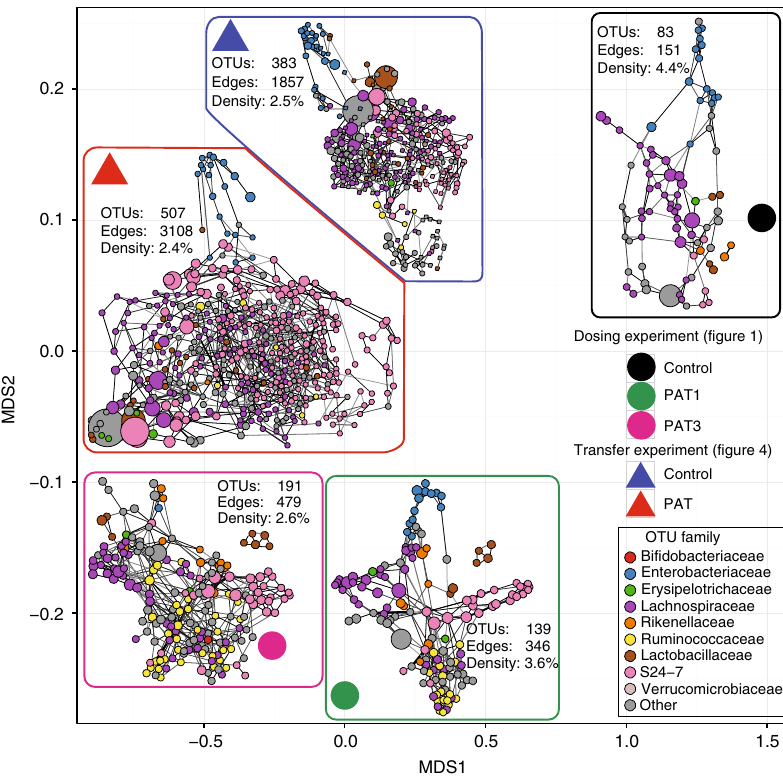
Fig. 5 Network properties recapitulate experimental perturbation. Networks were inferred using the SPIEC-EASI pipeline. To compare graphs, a two-dimensional embedding of graphlet correlation distances (using multidimensional scaling (MDS)) was used with the network positions shown as circles (from the dosing experiment (see Fig. 1)) or triangles (from the transfer experiment (see Fig. 4)). The corresponding networks on the MDS plot were overlaid near their respective positions in the embedding, and shown in a force-directed layout. Within each graph, nodes are colored by OTU family, with size proportional to (geometric) mean abundance, and edge width proportional to con fi dence score, as determined by stability selection. Each panel shows the number of OTUs (identi fi ed as those present in > 20% of samples), corresponding number of edges and calculated edge density (predicted edges/number of pairs of